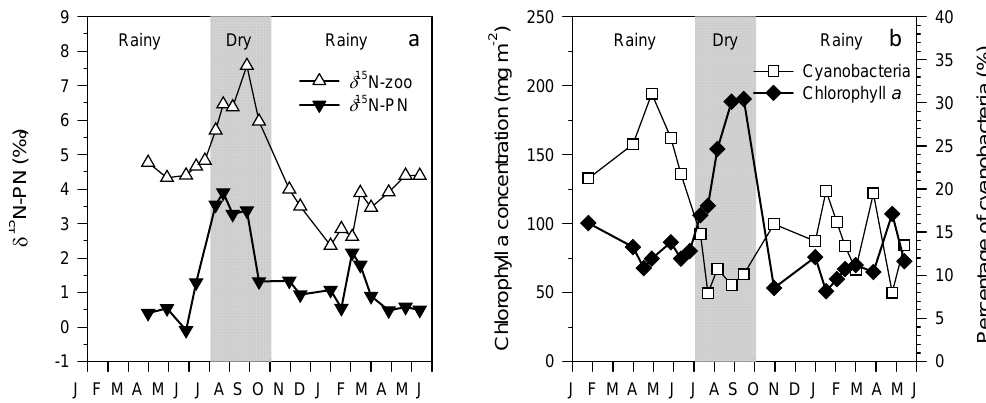
Figure 5. Temporal variability of (a) the δ 15 N signature of the particulate nitrogen (PN) pool and zooplankton in the mixed layer, and (b) the chlorophyll a concentration (mgm − 2 ) and the relative contribution of cyanobacteria to the phytoplankton assemblage (percentage of biomass) in the mixolimnion, assessed from pigment analyses, between February 2012 and May 2013.